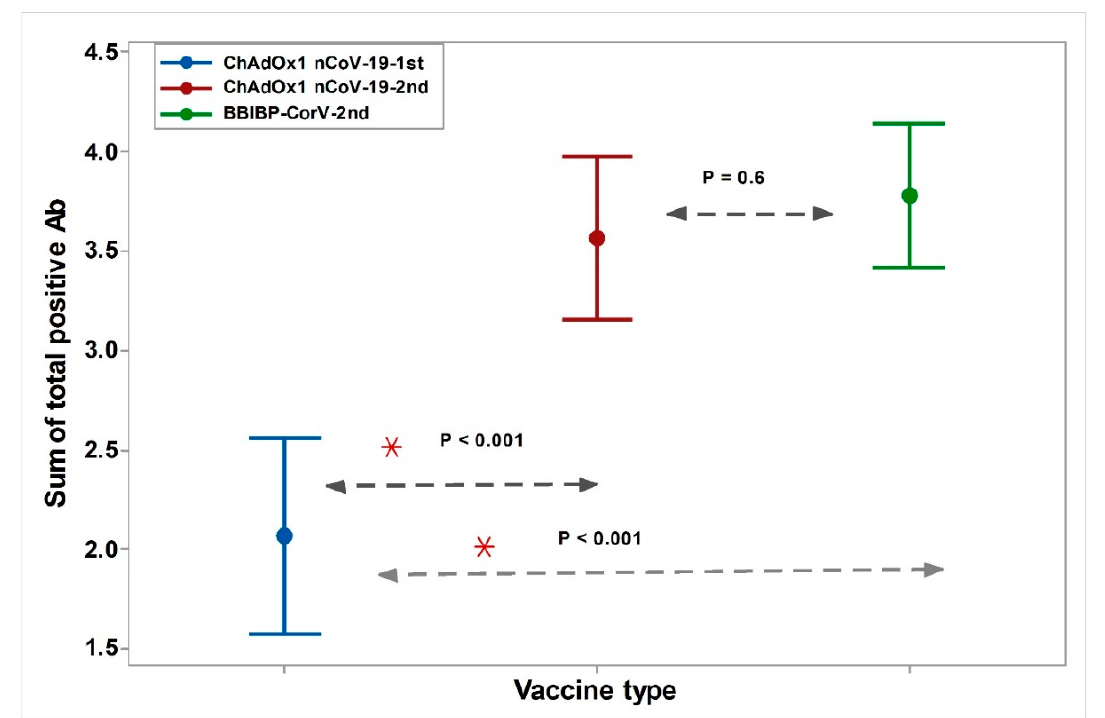
Figure 2. Cumulative total positive antibodies against SARS-CoV-2 proteins after the first and second doses of ChAdOx1 nCoV-19 and the second dose of BBIBP-CorV. * Test of significance: one-way analysis of variance with the Tukey method, p < 0.05 was considered significant. ChAdOx1 nCoV-19 1st: The first dose of ChAdOx1 nCoV-19 vaccine. ChAdOx1 nCoV-19 2nd: The second dose of ChAdOx1 nCoV-19 vaccine. BBIBP-CorV2nd: The second dose of BBIBP-CorV vaccine. Cutoff of